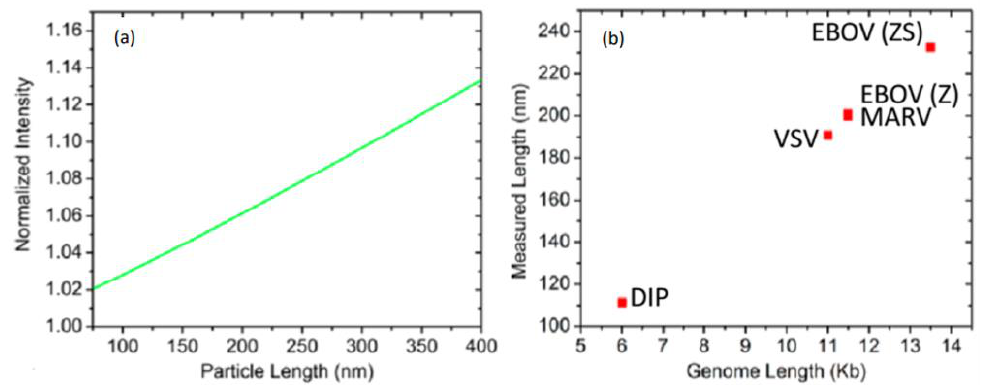
Figure 4. Discrimination of viruses with genome length. ( a ) The sizing curve that was composed with the responses obtained for varying lengths of a cylindrical particle with constant width, was used to calculate the dimension of virus particles based on VSV captured on the SP-IRIS chip surface. ( b ) The virus lengths measured with SP-IRIS for wtVSV, DIP, MARV, EBOV (Z), EBOV (ZS) [39]. Reproduced with permission from G.G. Daaboul, C.A. Lopez, J. Chinnala, B.B. Goldberg, J.H. Connor, M.S. Ünlü, ACS Nano; Published by American Chemical Society,